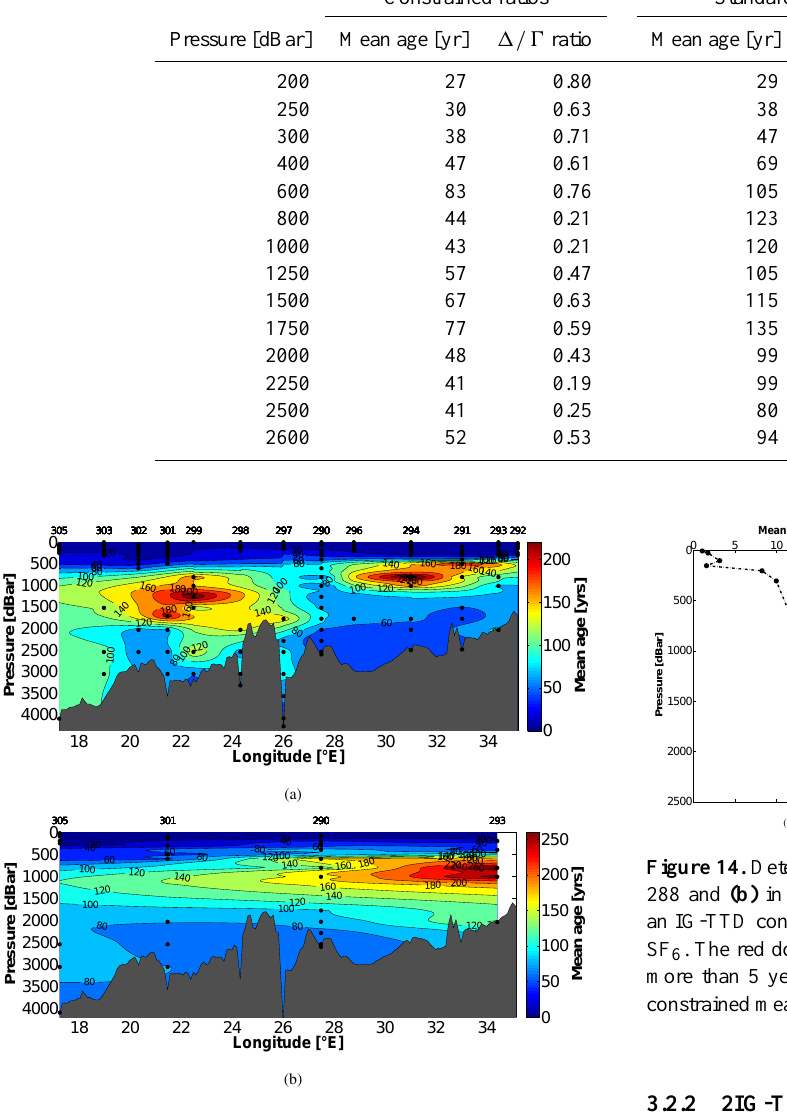
Figure 13. Mean age of the EMed based on an IG-TTD constrained Fig. 13: Mean age of the EMed based on an IG-TTD constrained by, ( a ) the transient tracer couple CFC-12 and SF 6 and ( b ) by (a) the transient tracer couple CFC-12 and SF 6 and (b) tritium tritium and SF 6 . and SF 6 .